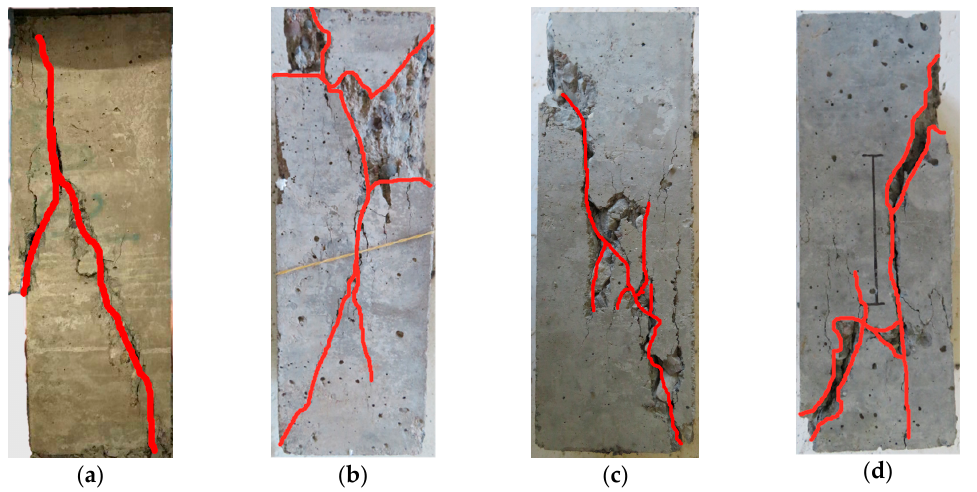
Figure 3. Typical failure patterns of the prism specimens: ( a ) normal-weight ordinary Portland cement concrete (NOPC); ( b ) lightweight ordinary Portland cement concrete (LOPC); ( c ) normal-weight alkali-activated concrete (NAAC); ( d ) lightweight alkali-activated concrete The stress–strain curves of all mixtures under axial compression are shown in Figure 4, in which the positive strain is the axial compressive strain and the negative one is the tensile strain in the transverse direction. Figure 4a demonstrated that the fly ash– BFSP-based NAAC and LAAC manufactured at ambient temperature exhibit a faster stress drop during the post-peak branch. This demonstrates that the compressive tough- ness is lower than that of the OPC concrete. However, the whole σ - ε curve of FA–BFSP- based NAAC and LAAC was not much different from that of corresponding OPC con- cretes. Previous findings [41] indicated that the σ - ε behavior of a heat-cured, low-calcium